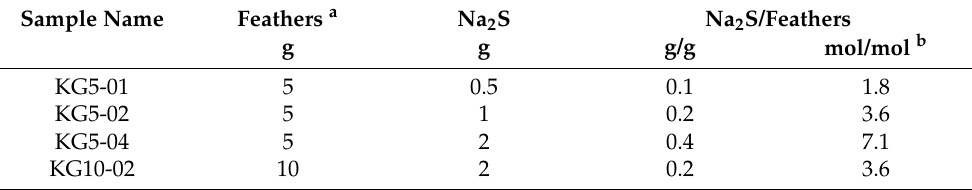
Table 1. Experimental conditions for the preparation of keratin hydrolysate as source for keratin